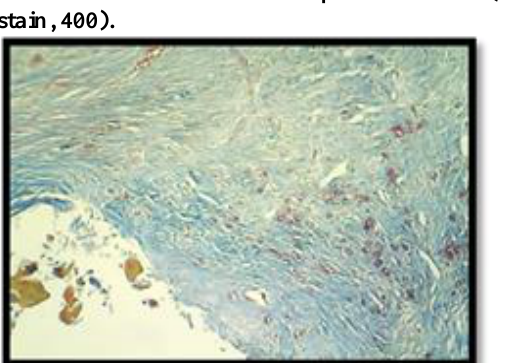
Figure, 16: UBM-treatment group at 8th week post implantation shows the construction of implant with delicate irregular collagen fibers (long arrow) (H&E stain, 400X).